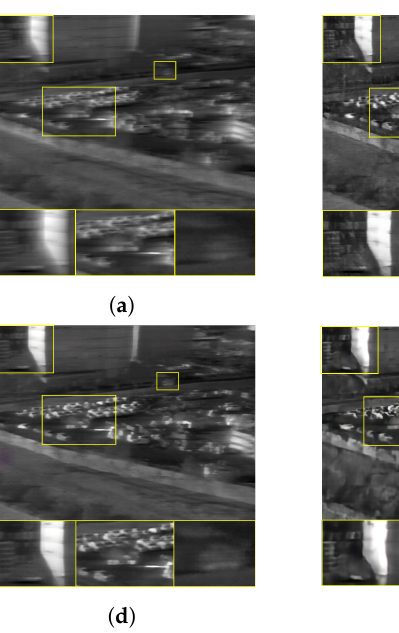
Figure 20. Qualitative comparison of motion deblurring results on the real blurry thermal